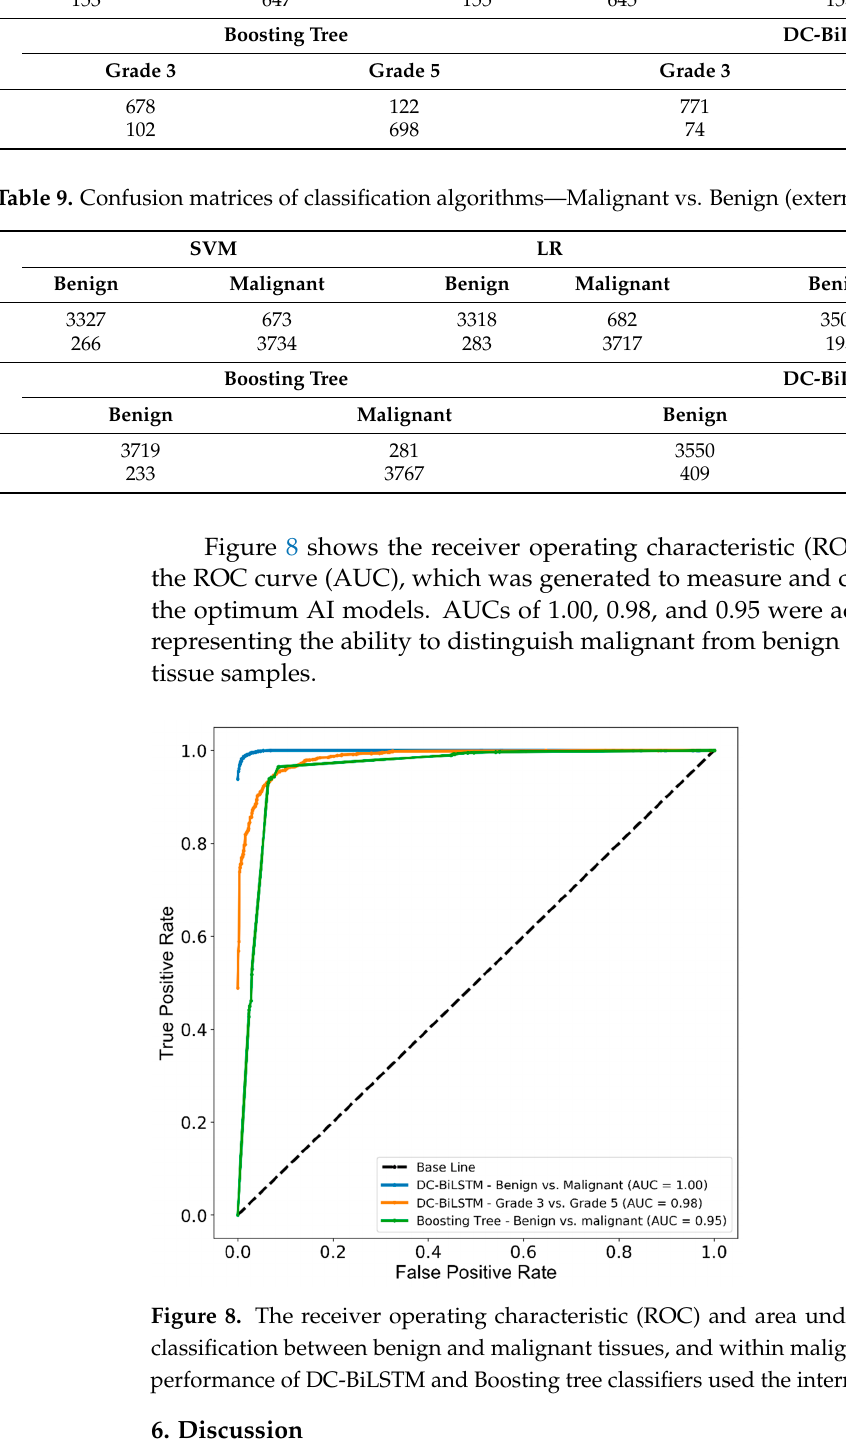
Table 8. Confusion matrices of classification algorithms—Grade 3 vs. Grade 5 (internal test set).